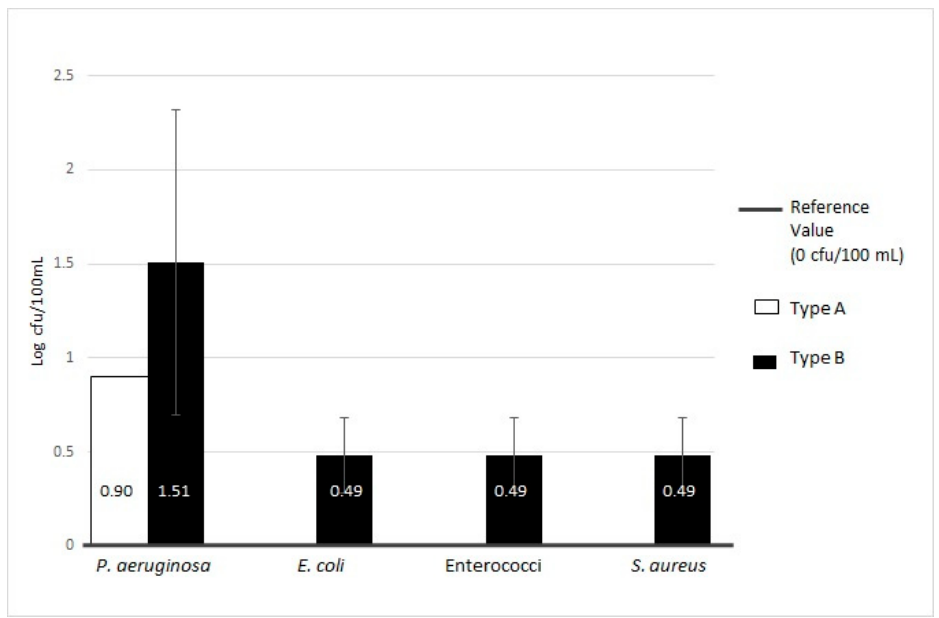
Figure 7. Microbiological contamination of total samples of Type A vs. Type B (MWDs) for Enterococci, Pseudomonas aeruginosa , Escherichia coli , and Staphylococcus aureus .